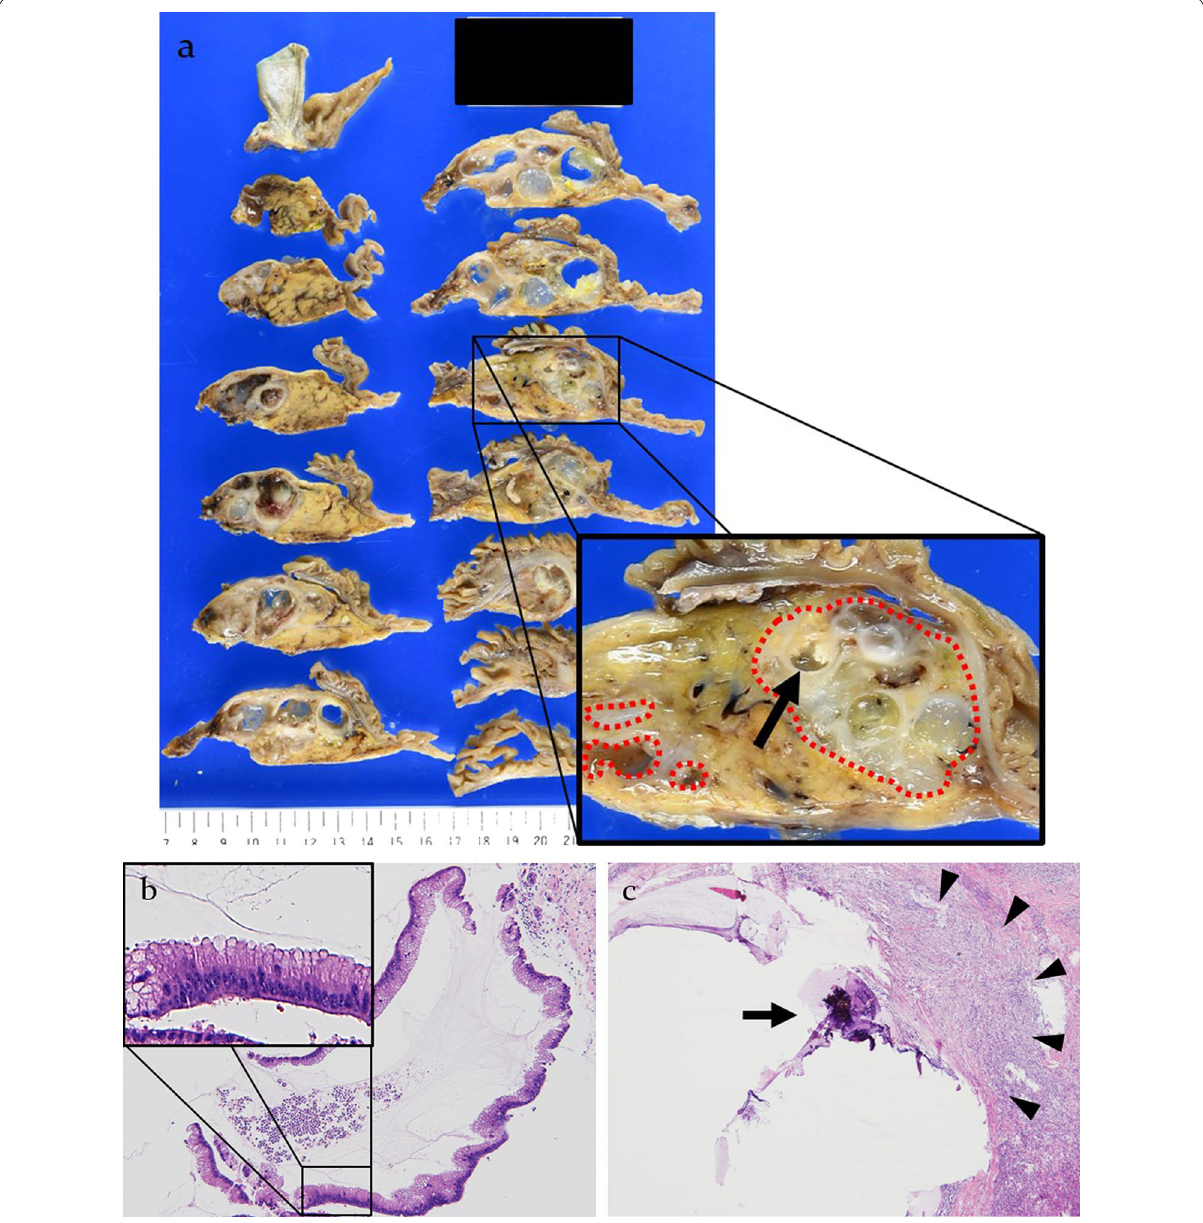
Fig. 4 a The 60 50 mm multilobular cystic lesion was observed in the pancreatic head. The cut surface of the resected specimen in the × pancreas head showed a large multilobular cystic mass filled with mucin and mural nodules. The partition wall of the mass was exceedingly hard, demonstrating calcification (black arrow). The precise area of the carcinoma component was described using the red dotted line